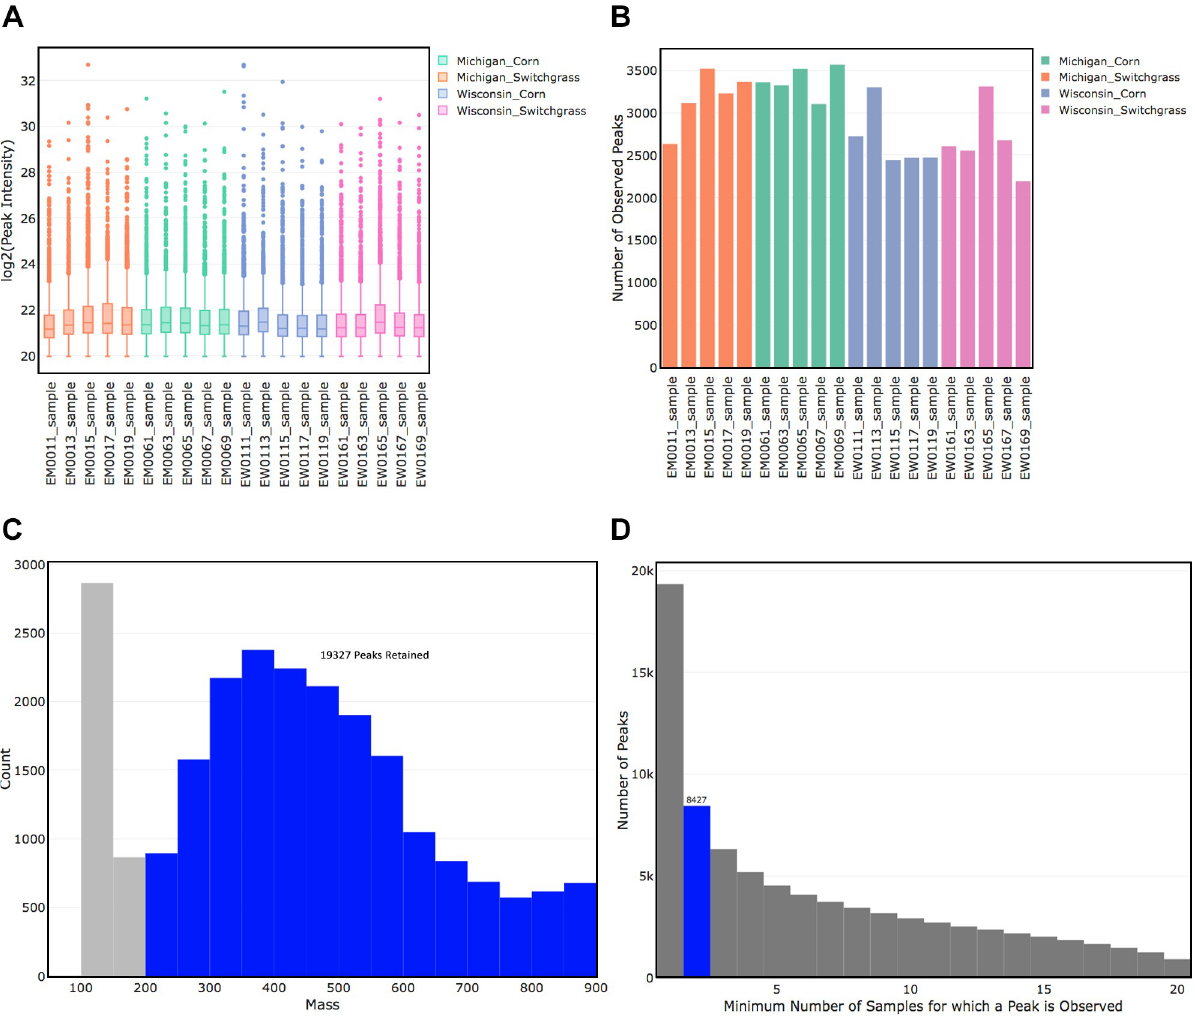
Fig 1. (A) Log2-transformed peak intensity profiles for each sample colored by group. (B) Number of peaks observed in each sample colored by group. (C) Histogram of all observed masses, with masses colored in blue representing those that would be retained after application of a mass_filter(). (D) Barchart corresponding to the minimum number of samples for which a peak was observed, with the height of the bar giving the number of peaks for which this is true for 1 to 20 samples. The highlighted bar gives the number of peaks remaining if the molecule_filter() requiring a peak to be observed in two or more samples is